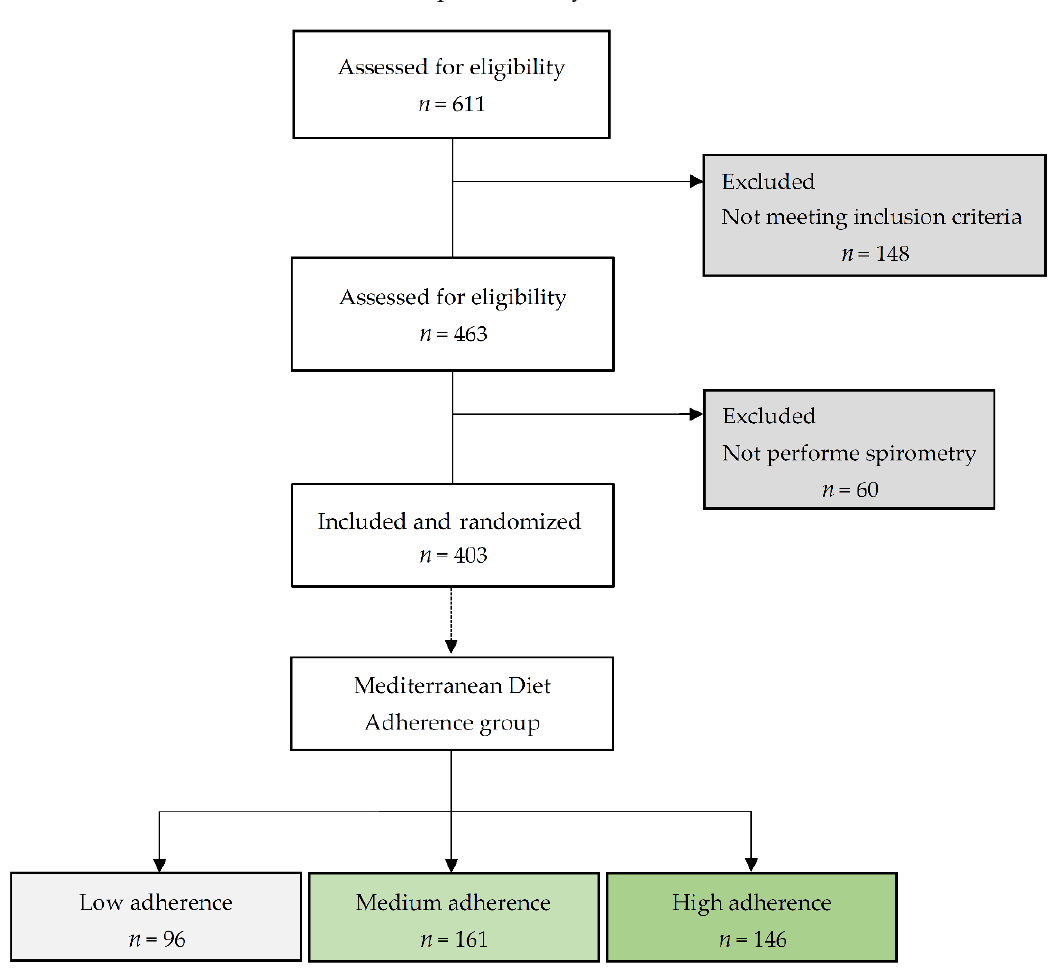
Figure 1. CONSORT diagram adapted for this study: Screening, randomization and initial distribu- tion of the MEDISTAR study participants. Adherence to the Mediterranean Diet was assessed using the 14-item MEDAS validated questionnaire that considers low (0 – 6 points), medium (7 – 8 points) and high (9 – 14 points) adherence [19].